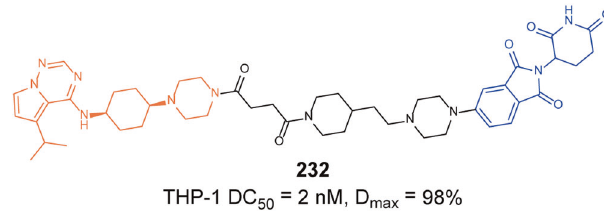
Fig. 78 The representative PROTAC targeting IRAK3